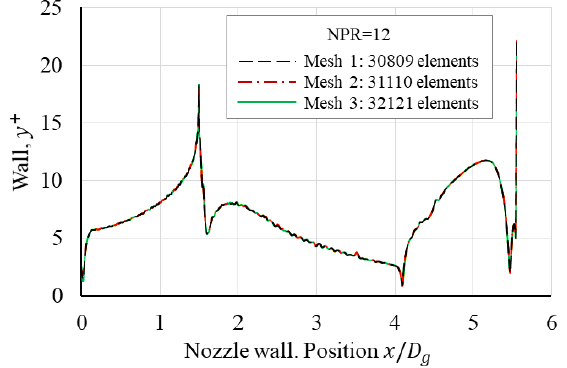
Figure 3. The behavior of y + in the nozzle wall for three meshed domains. Source: